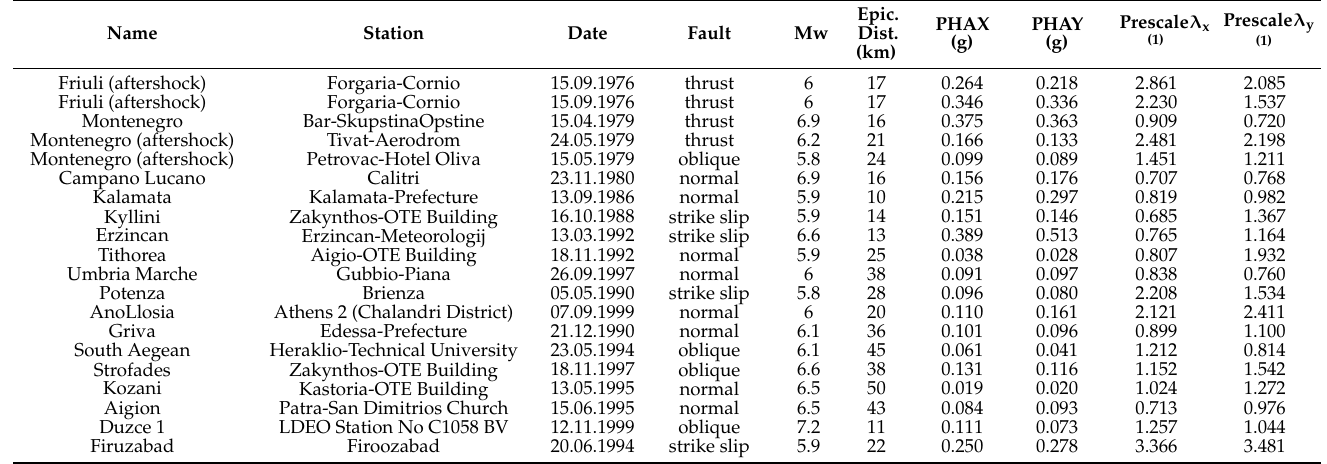
Table A2. Selection and pre-scaling of accelerograms for Ground Motion Set B.